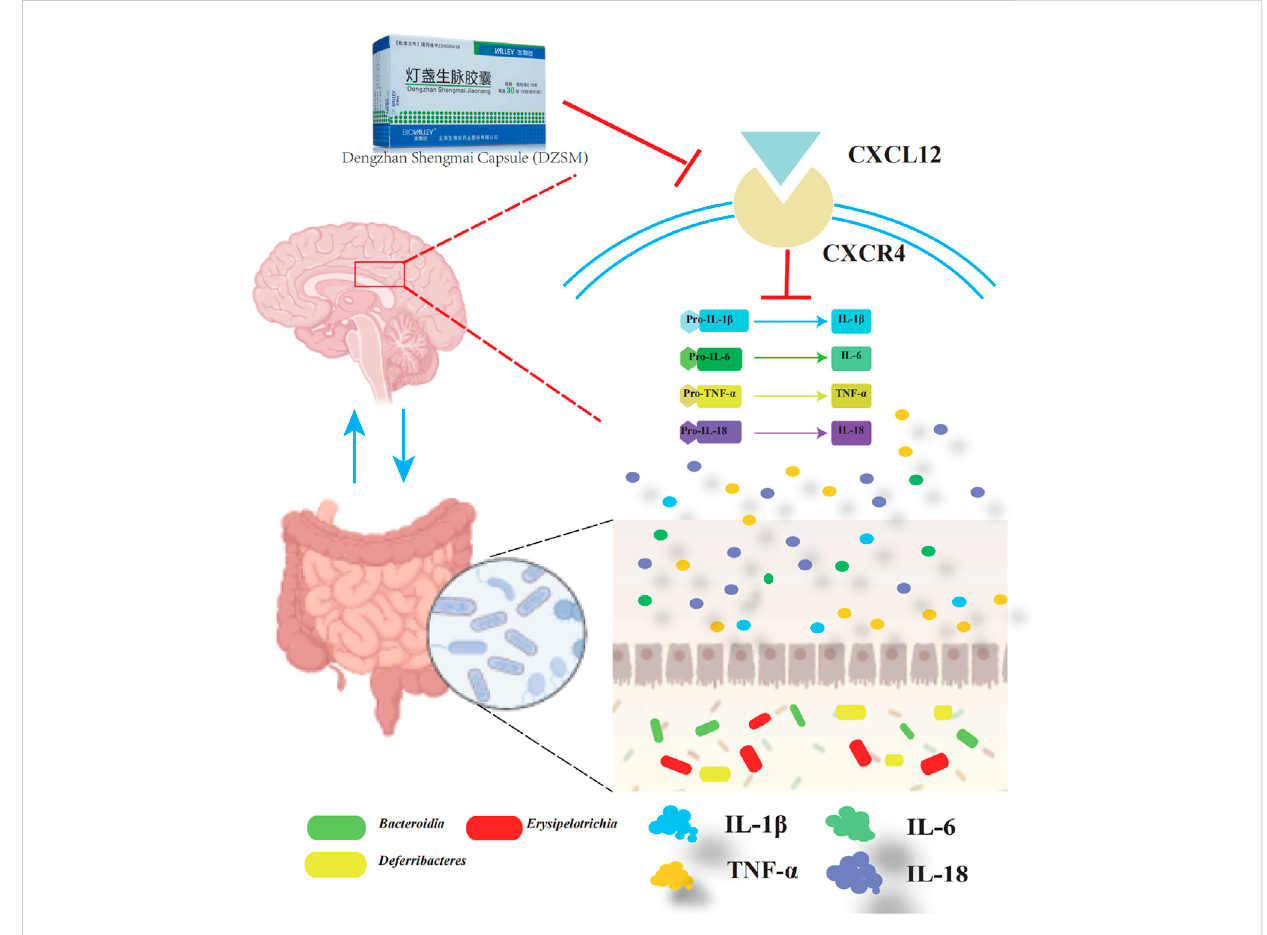
FIGURE 9 Overview of the cognitive impairment-ameliorating mechanism of DZSM via CXCL12/CXCR4 regulation and microbial improvement.